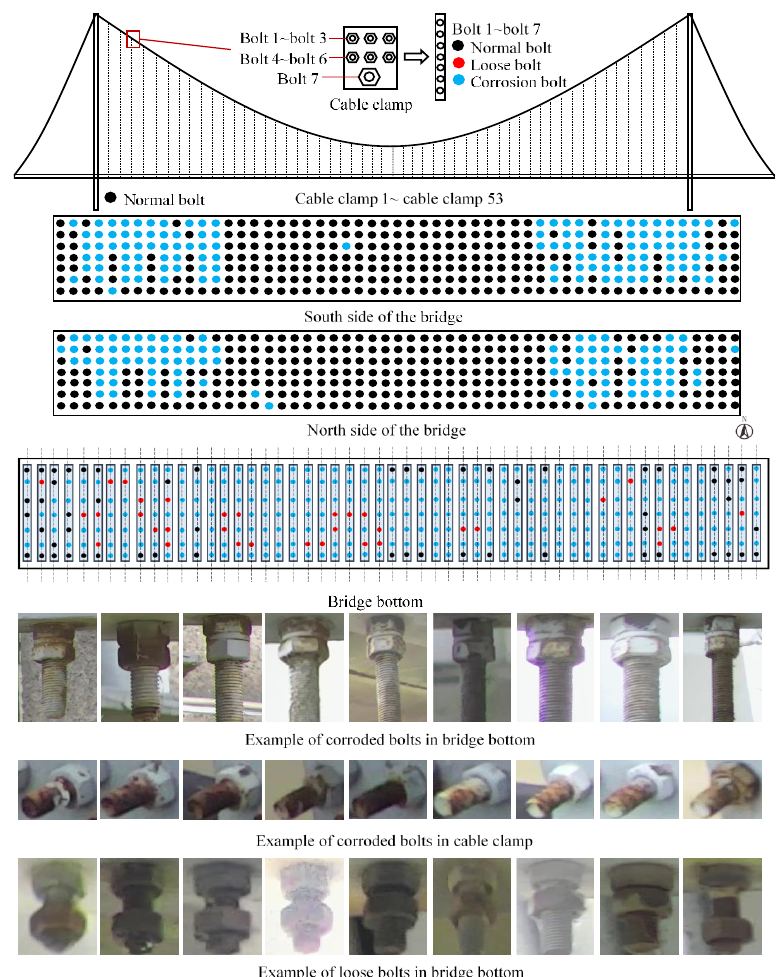
Figure 15. Bolt inspection result of the suspension bridge.